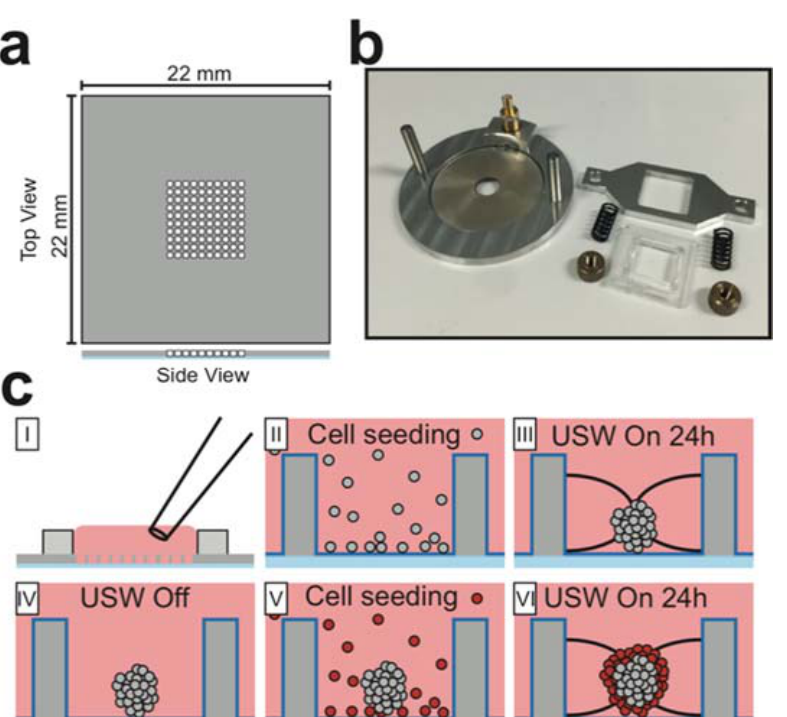
Figure 1. Ultrasound based layered multicellular tumor spheroids (MCTS) formation. The multi-well microplate ( a ) consists of a 22 × 22 × 0.3 mm 3 silicon plate with 100 microwells (350 × 350 μ m 2 ) etched straight through the silicon layer and a 170 μ m thick glass plate bonded to the bottom. The multiwell microplate was fixed on a circular transducer ( b ) with immersion oil as coupling medium to introduce ultrasonic standing waves (USWs) into the microwells. To form core-shell MCTSs ( c ), cells were seeded with a regular pipette into the shared medium reservoir above the microwells (I) and allowed to sediment to the well bottoms (II). The microplate was then transferred to the transducer which was actuated with a frequency corresponding to the λ /2-criterion across the microwell width. The radiation forces trapped all cells in an aggregate in the microwell center for 24 h (III). The microplate was dissembled from the transducer (IV) and cells comprising the shell were seeded around the preformed MCTS core (V) before the radiation forces were reintroduced for 24 h to create the core-shell MCTSs (VI).